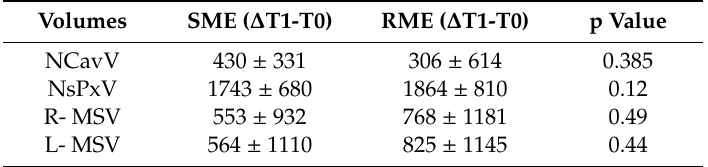
Table 4. Descriptive statistics (mean ± standard deviation) and independent t -test between